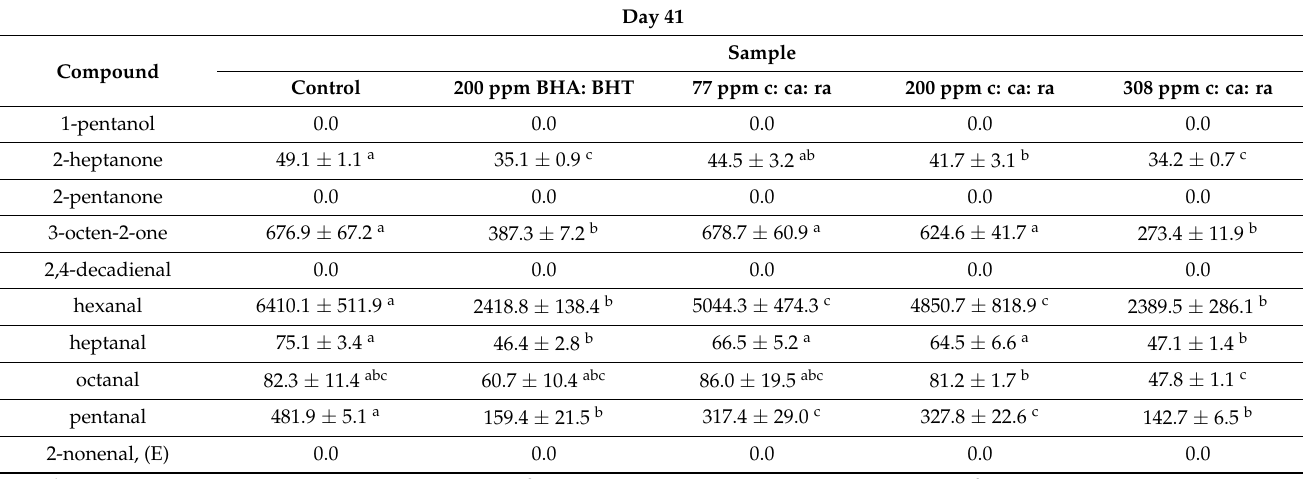
Table A8. Levels of volatile compounds ( µ g/kg of FFMP) as measured with HS-SPME-GC-MS analysis in FFMPs with or without antioxidants, after accelerated storage (40 ◦ C, RH 23%) for 41 days 1, 2, 3, 4 . Day 41 Sample Control 200 ppm BHA: BHT 77 ppm c: ca: ra 200 ppm c: ca: ra 308 ppm c: ca: ra